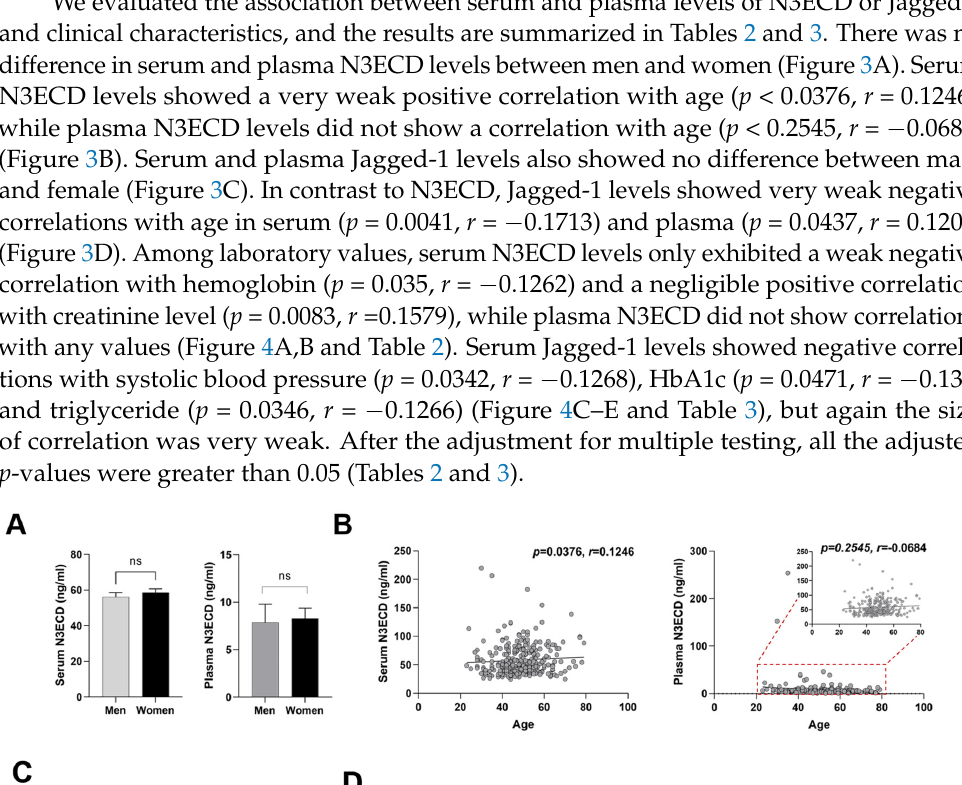
Figure 2. Correlations between N3ECD and Jag-1 levels. Positive correlations of serum ( A ) and plasma levels ( B ) between N3ECD and Jag1 ( n = 279). Results are representative of three independent ELISA experiments. The resulting Spearman’s correlation coefficient ( r ) and corresponding p -values are reported.